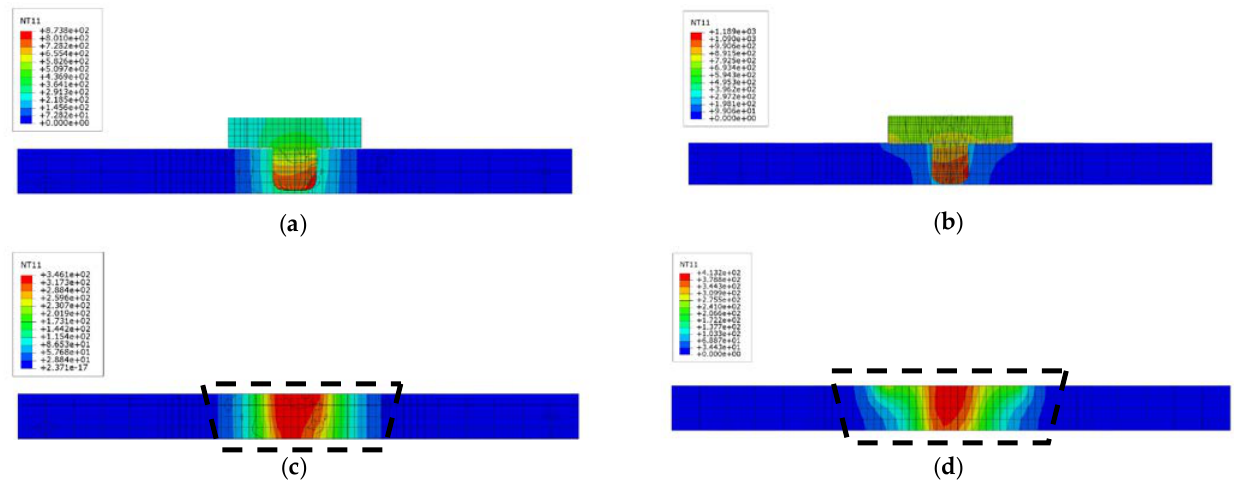
Figure 18. Temperature at the cross section with and without the tool (without tilt angle) ( a ) tool and tilt angle; ( b ) tool without the tilt angle; ( c ) cross section with the tilt angle; ( d ) cross section without the tilt angle.